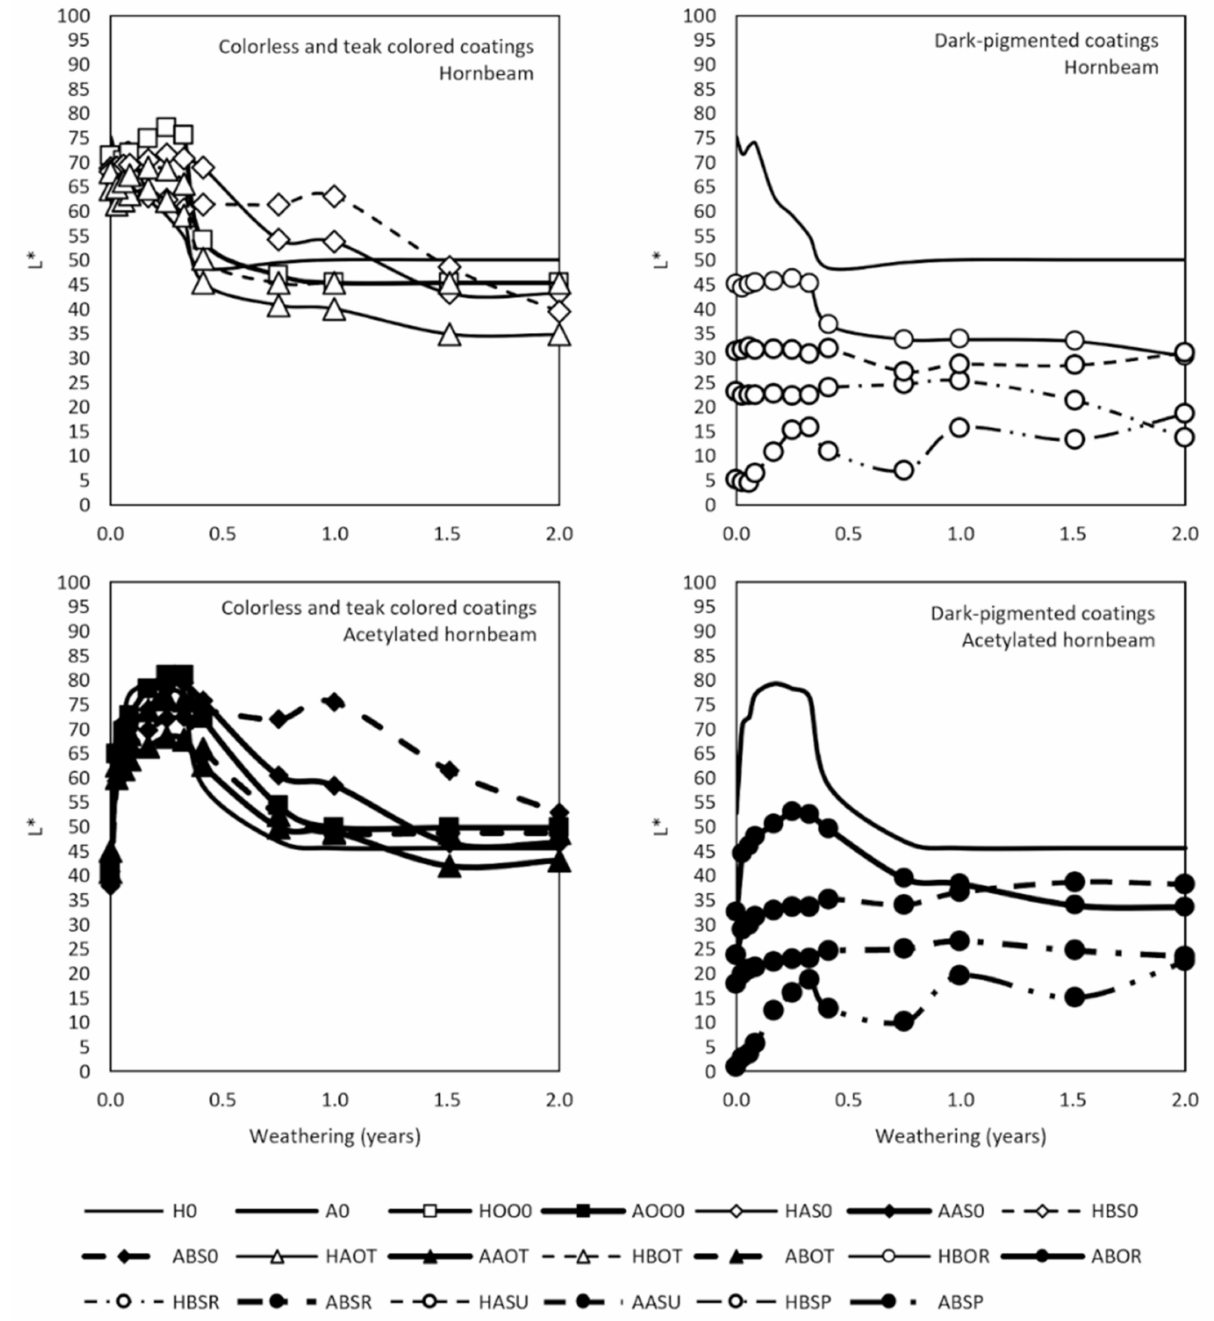
Figure 8. Change of lightness (L*) during two-year-long weather exposure. In the first weeks, there was an initial increment of a* in hornbeam samples; before they started greying, their color shifted to a darker yellow. Then a* decreased at different rates depending on the wood and coating type. The greatest a* increment was in BS0 before the coating failed, and the surface began to grey as with the other colorless coatings. BSP coated acetylated hornbeam also had a great increment of a*. The biggest a* reduction was in BOR, BOT, and AOT. ASU had the lowest ∆ a* (Figure